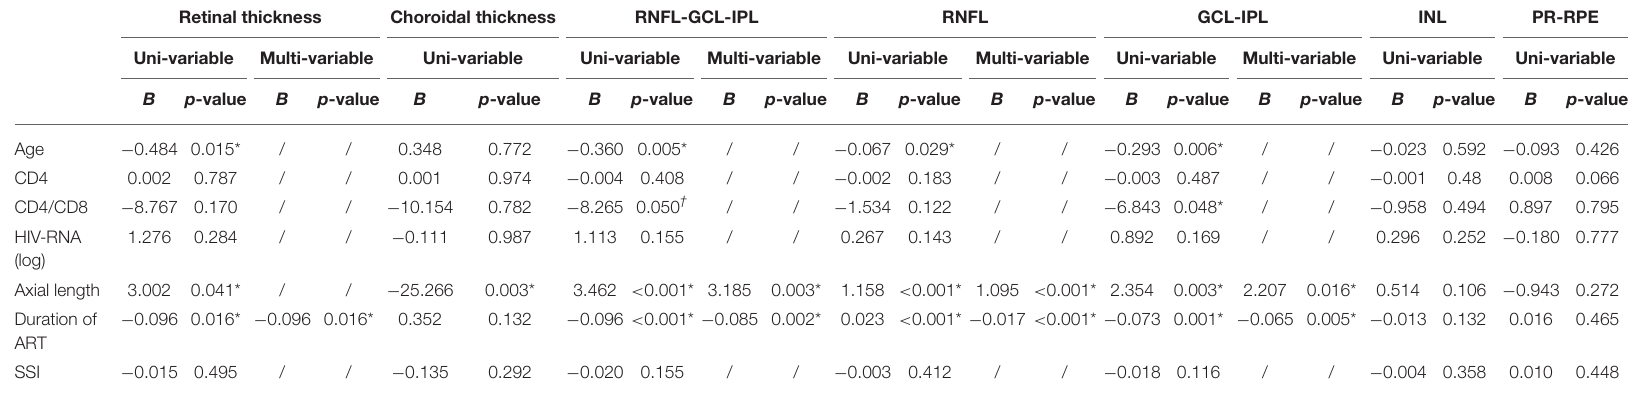
TABLE 4 | Multivariable linear regression analysis between macular structural parameters in the entire Early Treatment of Diabetic Retinopathy Study grid and systemic variables in all patients with human immunodeficiency virus infection (model